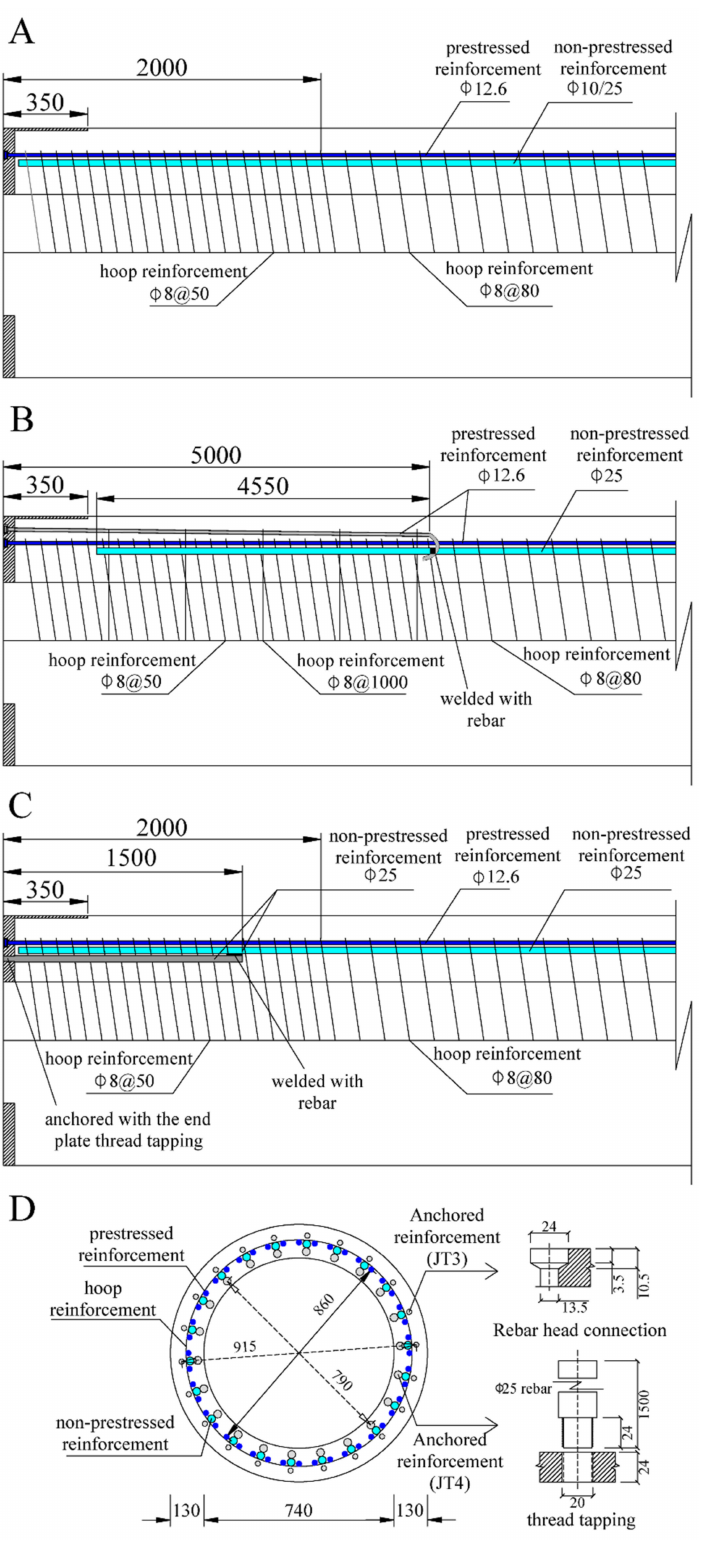
Figure 1. Schematic diagram of reinforcement of PRC pipe piles: ( A ) ZS1, JT1, and JT2; ( B ) JT3; ( C ) JT4; ( D ) cross-sectional reinforcement and end plate connection (unit: